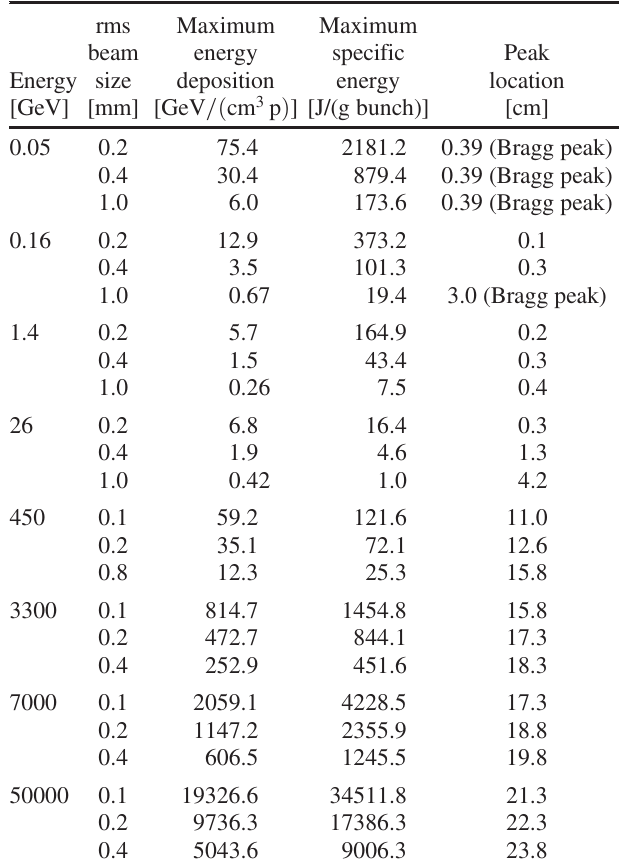
TABLE III. Summary of the energy deposition of protons in a solid copper target with typical beam